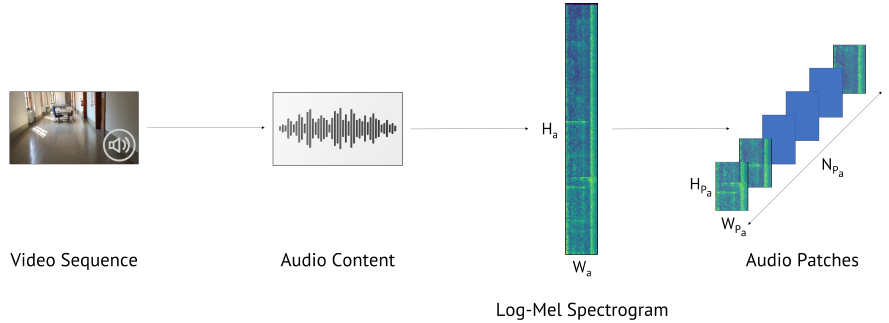
Figure 4. Extraction of audio patches from a video sequence. Once we select the audio content, we compute the LMS, which has size H a × W a . Then, we randomly extract N P × W H P P a a